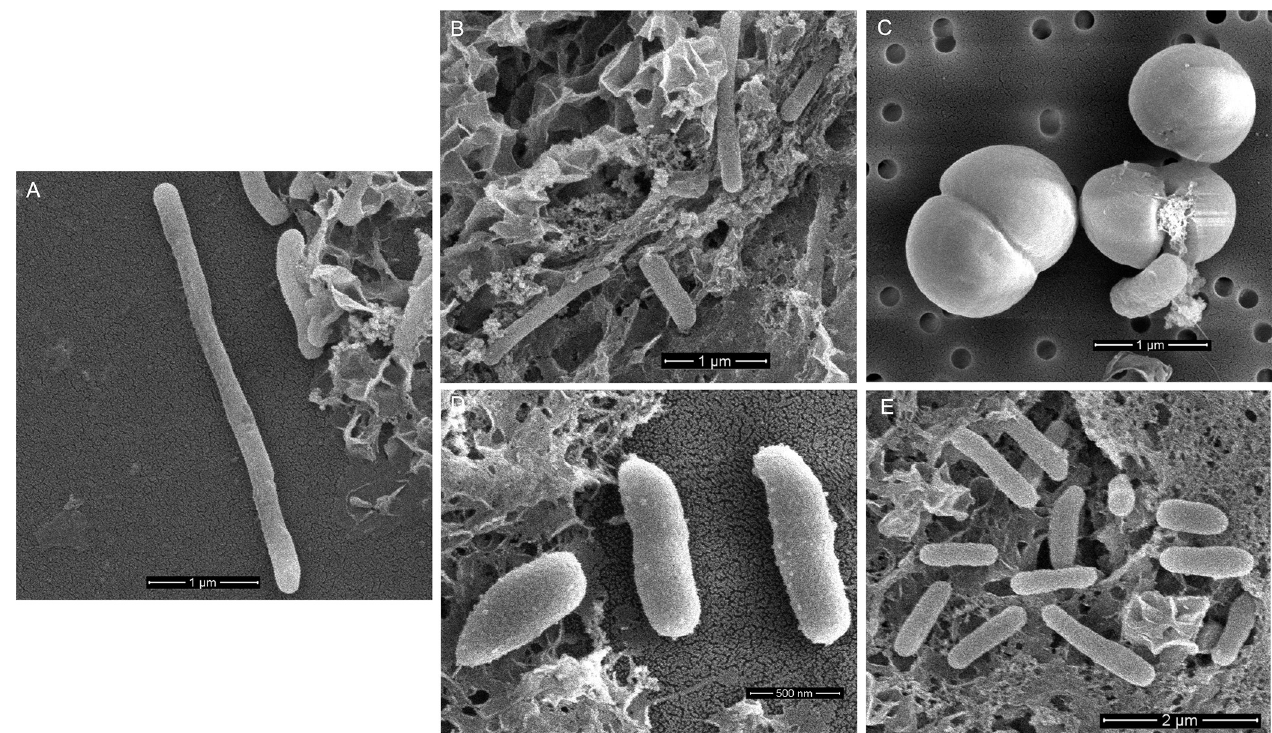
Fig 2. Scanning electron micrographs of isolated bacteria used in the experiment. ( A) Cellulophaga sp. (Cel) (B) Polaribacter sp . (Pol) (C) Planococcus sp. (Plan) (D) Pseudoalteromonas sp. (Palt) (E) Vibrio sp. (Vib).